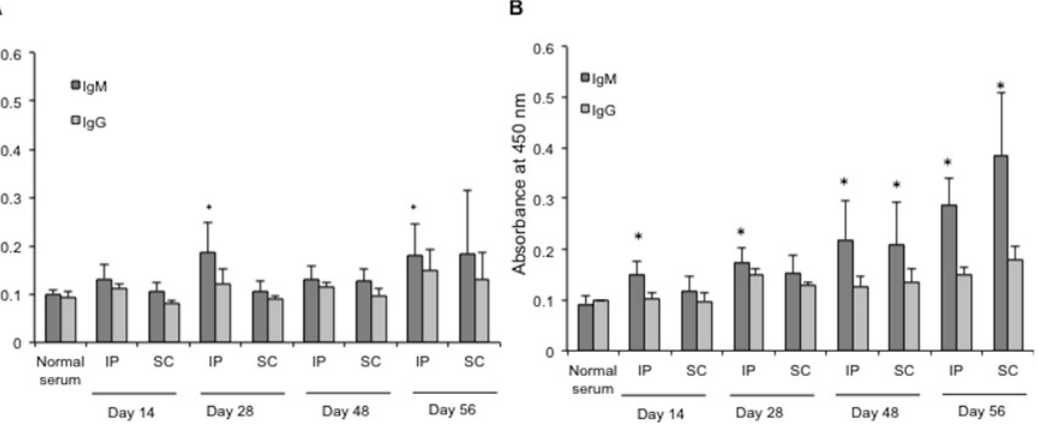
Fig 6. Detection of GlcCer antibody in the sera of different strains of mice following different route of administration. A) Sera of CBA/J mice treated with weekly administration of GlcCer + adjuvant using interaperitoneal (IP) or subcutaneous (SC) administration. * , P < 0.05, IgM day 28 or day 56 versus IgM normal serum (day 1). B) Sera of BALB/c mice treated with weekly administeration of GlcCer + FA. Six mice per group were used. Plots show the results of ELISA experiments performed using purified GlcCer as antigen. * , P < 0.05, IgM at day 14, 28, 48, or 56 versus IgM normal serum.